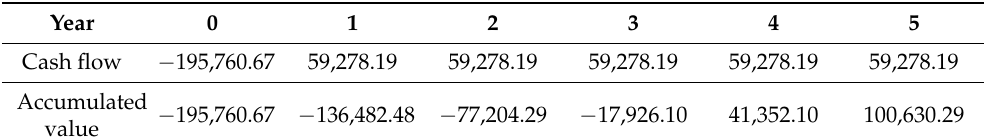
Table 11. Annual cash flow for palm oil neutralization sludge ( Elaeis guineensis , Jacq) and simple payback analysis.